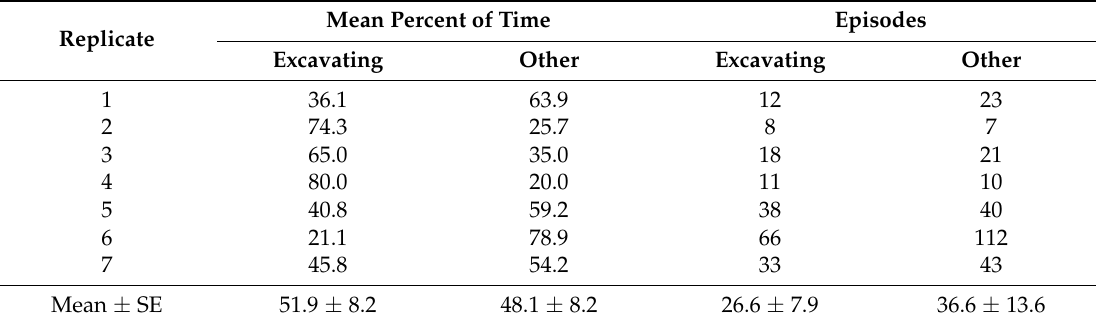
Percent of time spent excavating and in other activities by solitary neonates of Cactoblastis cactorum .